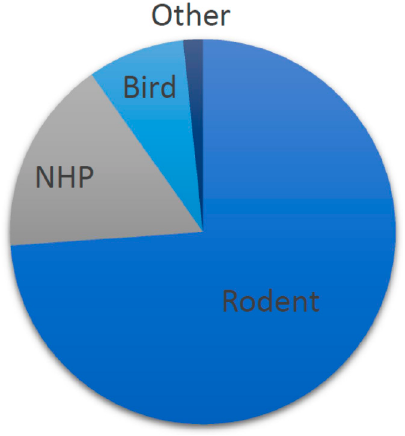
Figure 2. Animals used in included studies.